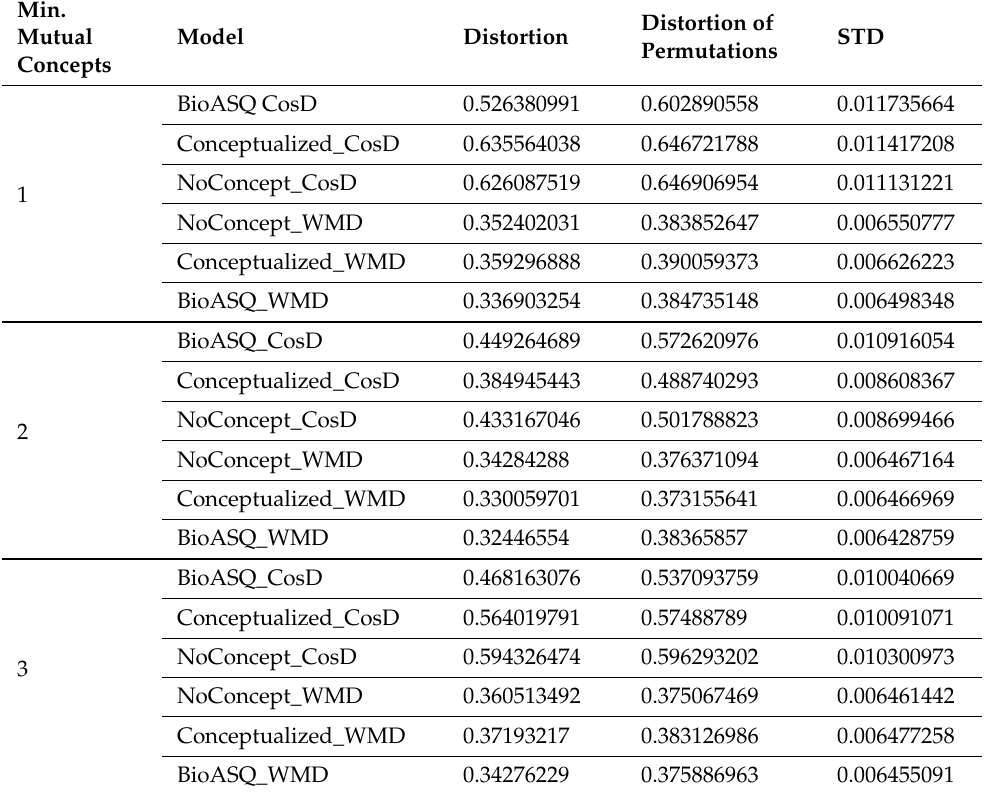
Table A1. Using sentences in recommendations and minimum mutual concepts . This table shows the values obtained in additional experiments, where full document guidelines were modified by attending to concepts in sentences (see above). Column 1 refers to the number of concepts overlapping with summaries. Distortion shows the distortions of graphs produced using corresponding models from Column 1. As before, in Table 6, the distortion depends on how we measure the distances; however, the shapes of the distributions are very